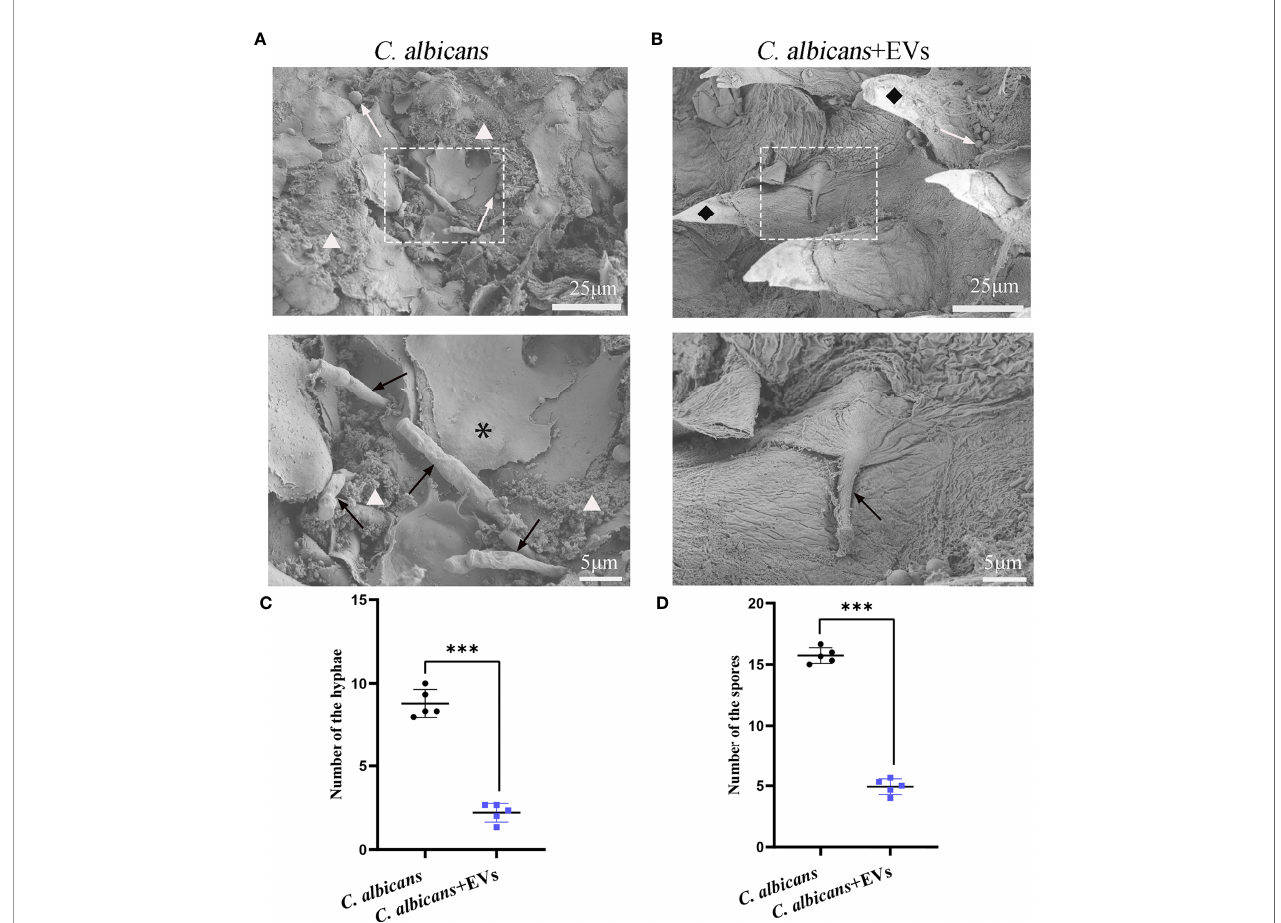
FIGURE 10 | SEM evaluation of the tongue dorsum of the mice. (A) Representative SEM images of the C. albicans group. The presence of hyphae (black arrow) penetrating perpendicularly into the tissue is noted. Spores (white arrow), bacteria and bio fi lm ( △ ), keratin desquamation (*) can be observed. (B) Representative SEM images of the C. albicans + EVs group. Hyphae (black arrow), spores (white arrow), fi liform papillae ( ♦ ) can be observed. The scale bar of the upper row represents 25 m m. The scale bar of the bottom row represents 5 m m. (C) Analysis of hyphal number. The C. albicans + EVs group had signi fi cantly fewer hyphae than the C. albicans group. (D) Analysis of spore number. The C. albicans + EVs group had signi fi cantly fewer spores than the C. albicans + EVs group. Statistical signi fi cance was tested by Student ’ s t-test. ***P